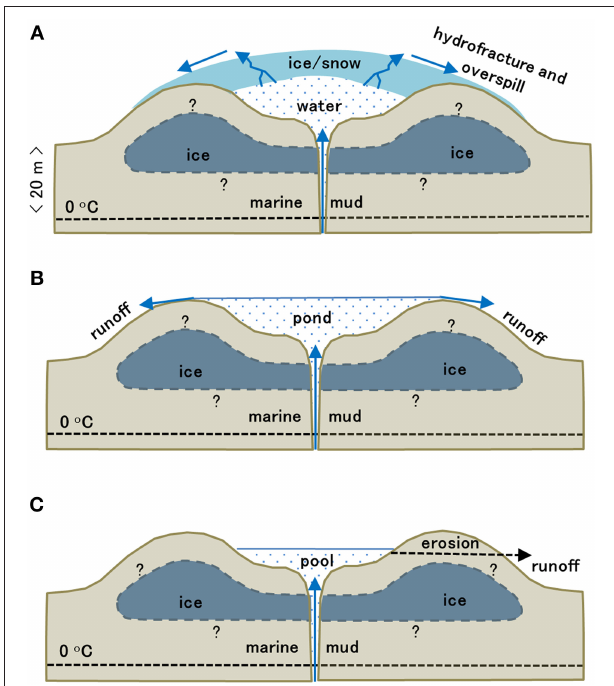
FIGURE 2 | Seasonal development of the Lagoon Pingo system, showing the winter (A) , early (B) , and late summer (C) configurations. Question marks indicate uncertainty in the sub-surface ground ice